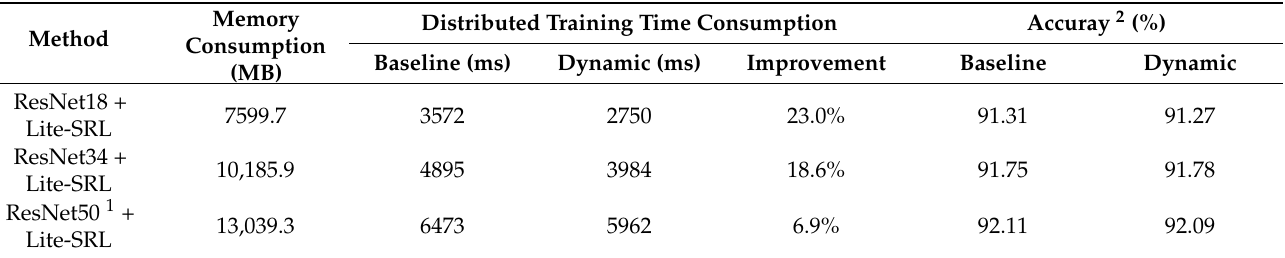
Table 7. Distributed Training Time Consumption, corresponding to the illustration in Figure 15.